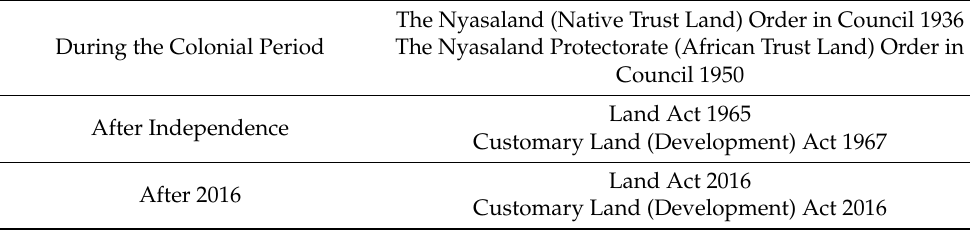
Table 2. Main land laws and policies in different periods in Malawi.